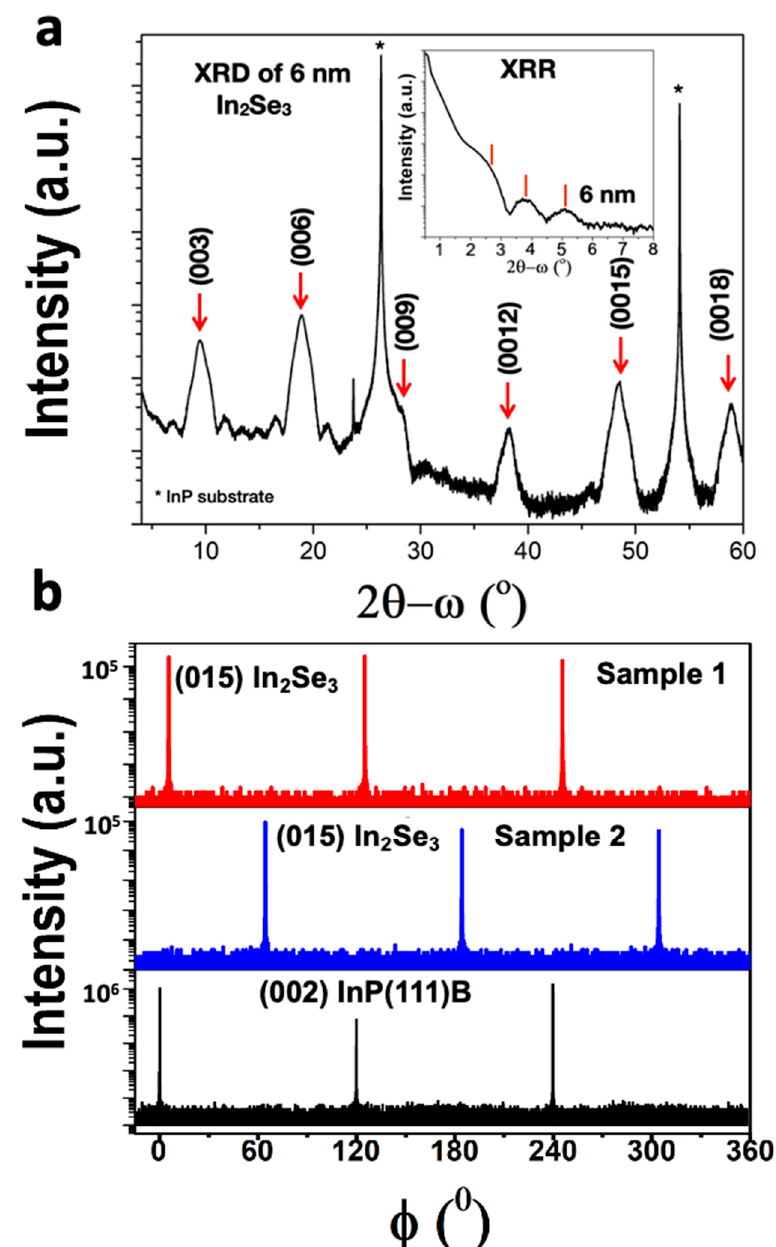
Figure 3. X-ray diffraction (XRD) ( a ) 2 θ - ω scan of 6 nm thick In 2 Se 3 layer; the inset shows X-ray reflectivity (XRR) of the In 2 Se 3 layer with distinguishable oscillations. ( b ) φ scan of (015) plane of two different samples of In 2 Se 3 and the (002) plane of InP(111)B substrate.